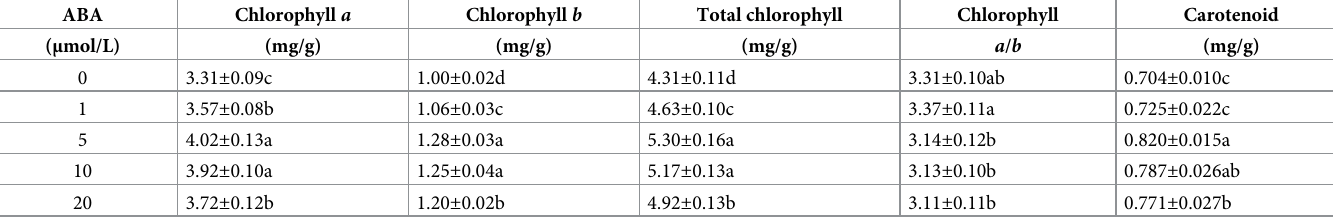
Table 2. Photosynthetic pigment content in P . frutescens